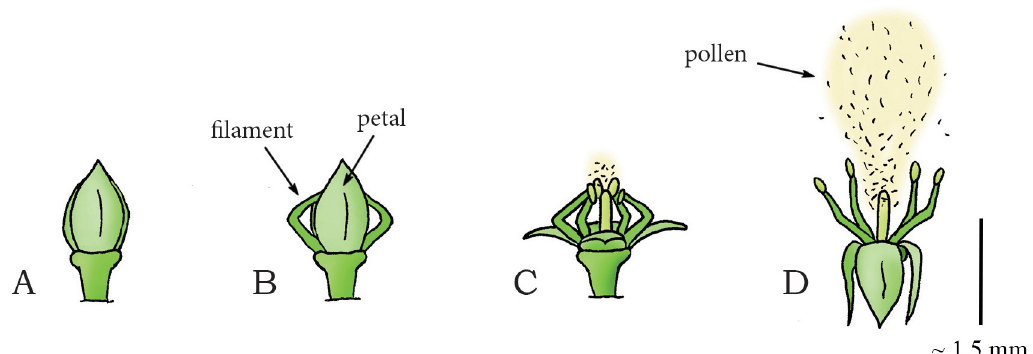
Fig 12. Swelling coiling catapult mechanism in Cornus canadensis . (A) Immature flower bud of C . canadensis . (B) Mature flower bud with filaments emerging from between the petals as the former have grown faster than the latter. (C – D) When a critical pressure is reached, dehiscence of the connection that hold the petals together allow the petals and filaments to unfold rapidly, releasing the stored elastic energy and discharging the pollen into the air. Drawings based on high-speed video images in [73]. Scale bar 1.5